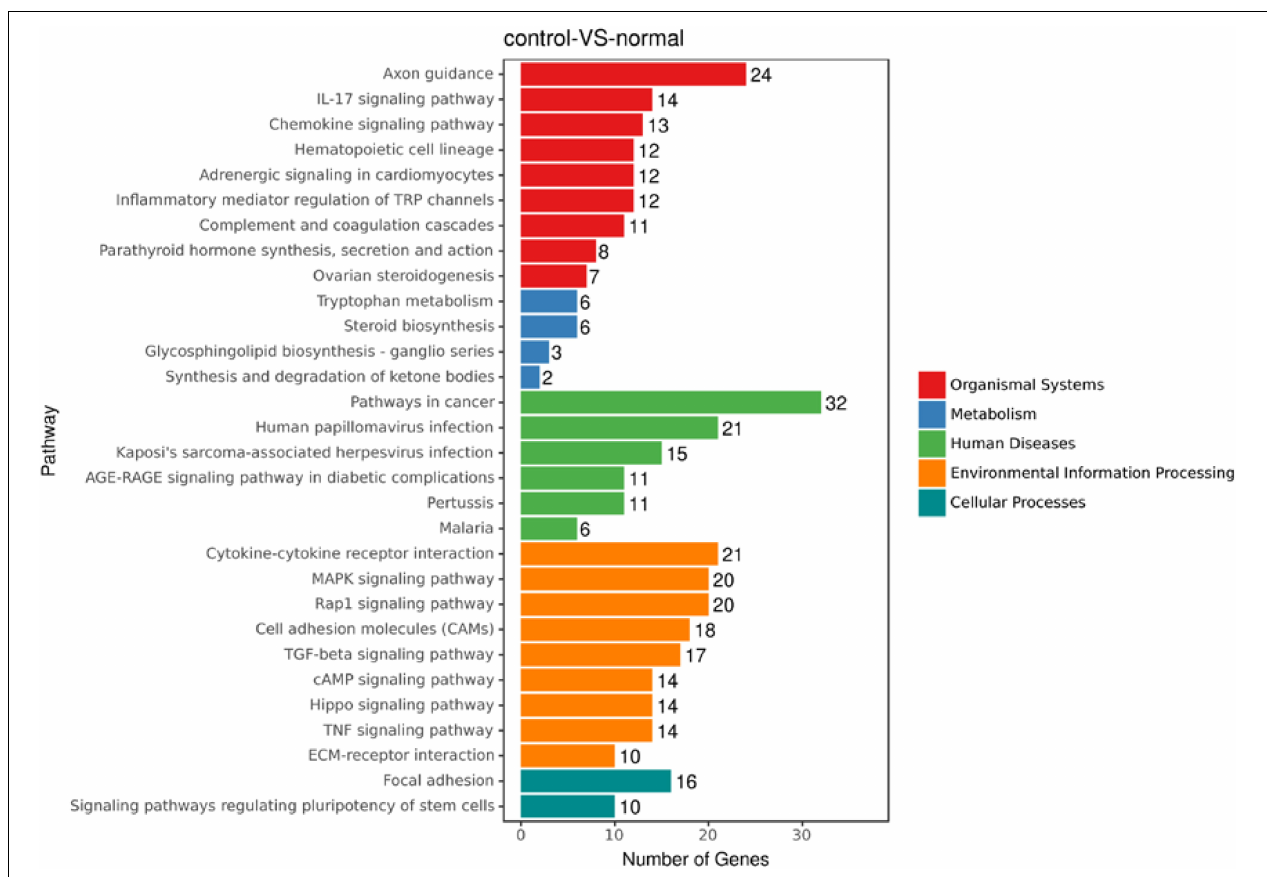
FIGURE 3 | An enrich mean analysis of pathways for DEGs based on the KEGG database. An enrich mean analysis of pathways for DEGs based on the KEGG database. The horizontal and vertical axes represent the enrichment score of – log p and the pathway category, respectively.